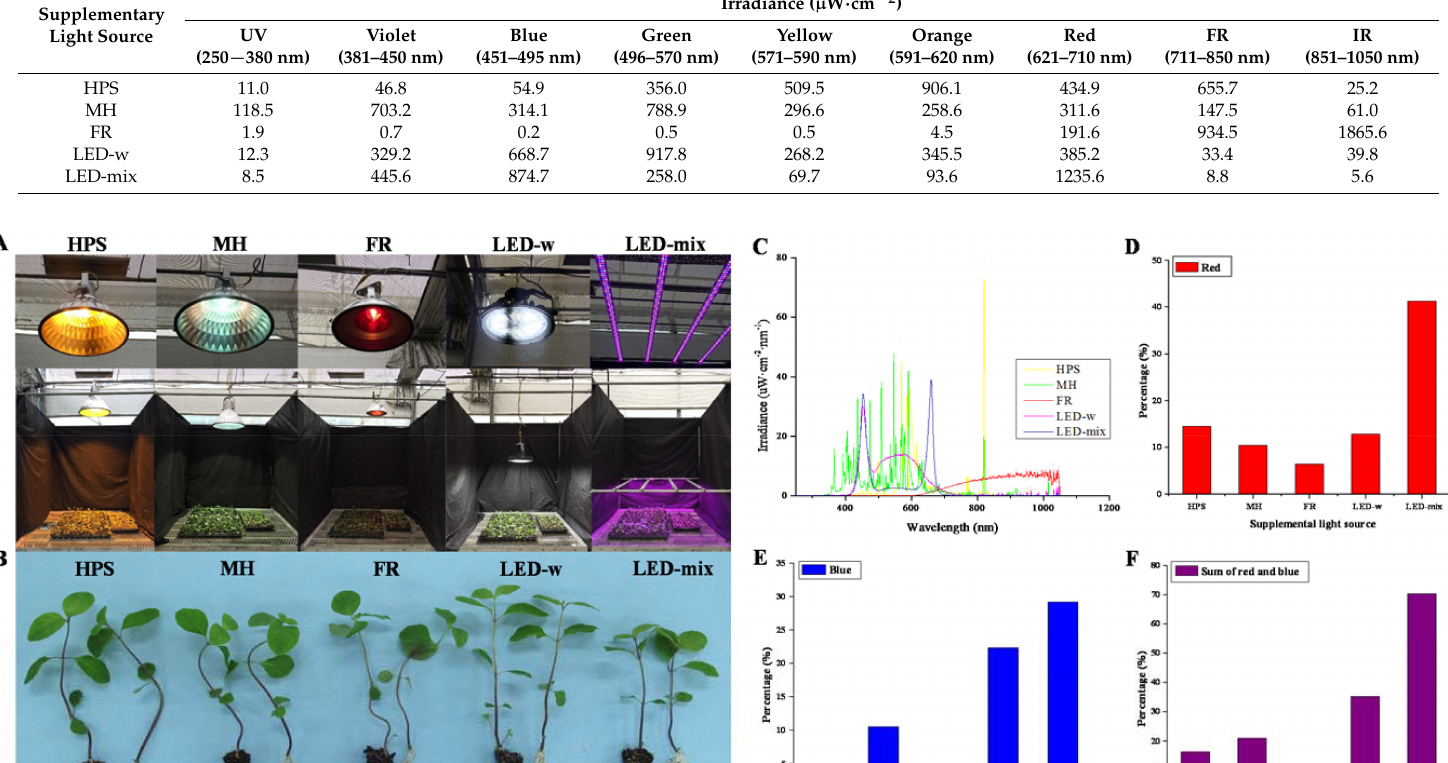
Table 1. The irradiance distribution of the supplementary light sources.